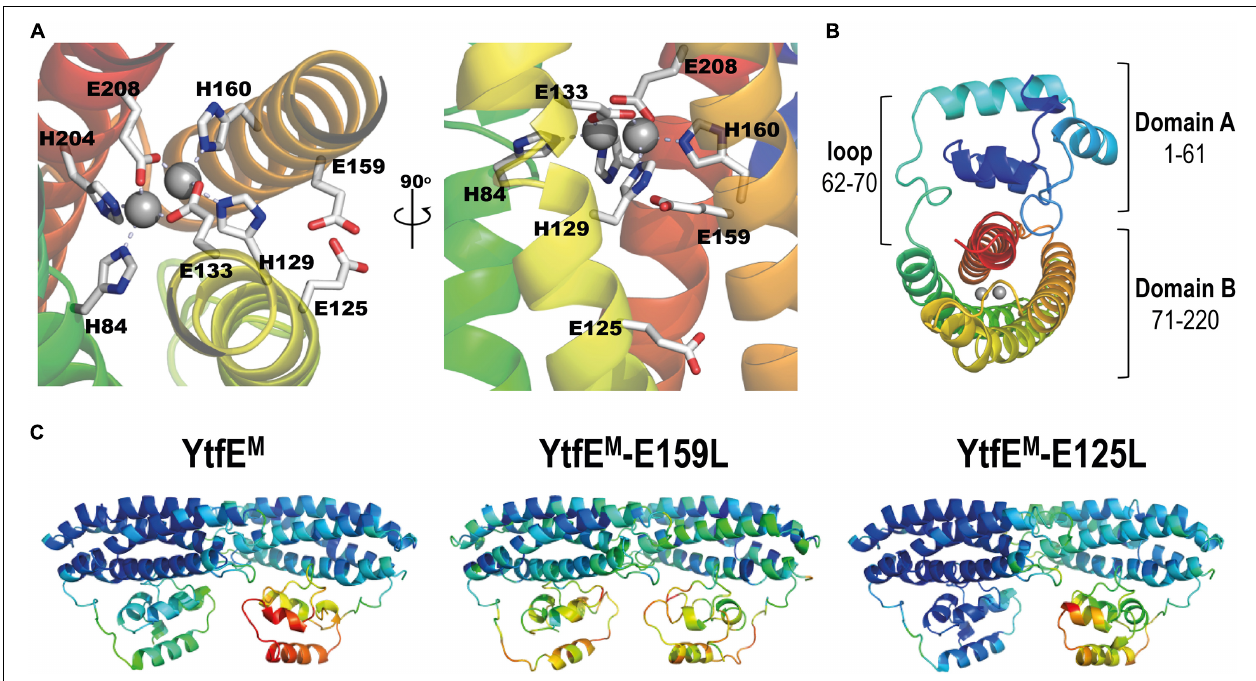
FIGURE 2 | E. coli YtfE M overall structure. (A) Detail views of the YtfE M di-iron center, its coordinating residues, and residues E125 and E159 highlighted in light gray (left panel view is rotated 90 ◦ about a vertical axis from first panel). (B) Cartoon representation of the E. coli YtfE M monomer (chain A) showing the two domains that are connected by a loop. In (A,B) the monomer structure is rainbow colored from dark blue in the N -terminal to red in the C -terminal. The di-iron site is represented as gray spheres. (C) Cartoon representation of the E. coli YtfE M , YtfE M -E159L, and YtfE M -E125L subunits present in the asymmetric unit, colored according to their B-factor values (the di-iron site is